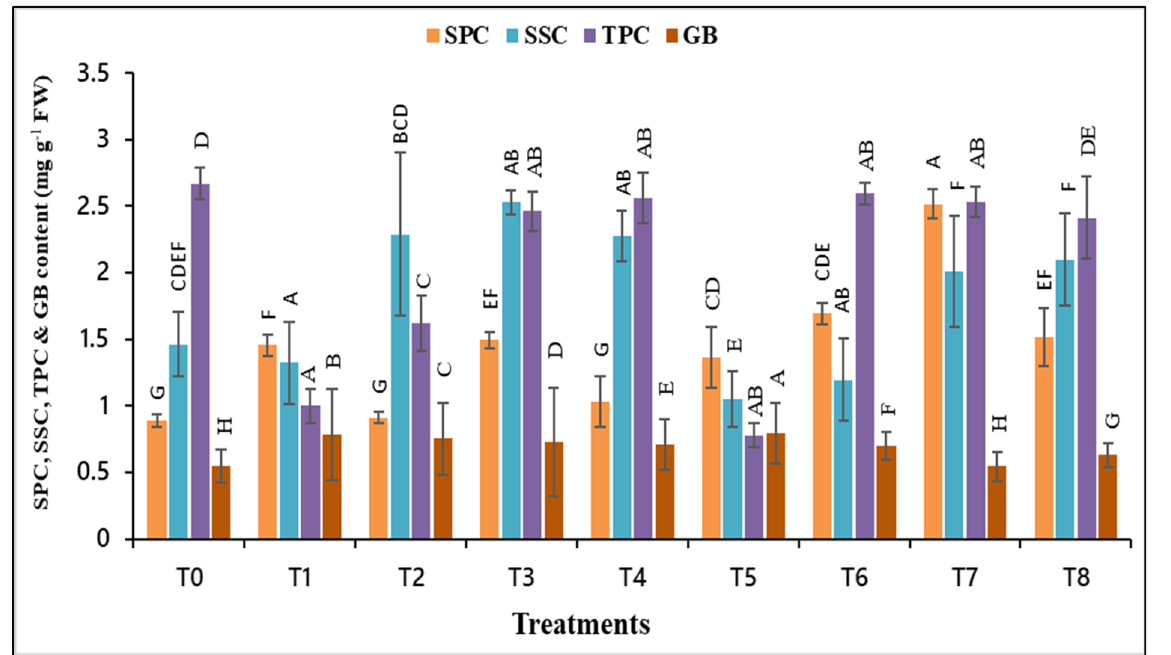
Figure 2. Effect of AsA and/or α -toc on soluble protein content (SPC), soluble sugar content (SSC), total proline content (TPC), and glycine betaine (GB) of A. sativa under drought stress. Different alphabetical letters indicate significant differences among treatments at p < 0.05, according to the LSD test. (T0) control: normal watering + 0 mg AsA and α -toc, (T1): 15 days drought + 0 mg AsA and α -toc, (T2): 15 days drought + 200 mg AsA, (T3): 15 days drought + 200 mg α -toc, (T4): 15 days drought + 200 mg AsA and α -toc, (T5): 25 days drought + 0 mg AsA and α -toc, (T6): 25 days drought + 200 mg AsA, (T7): 25 days drought + 200 mg α -toc, (T8): 25 days drought + 200 mg AsA and α -toc.